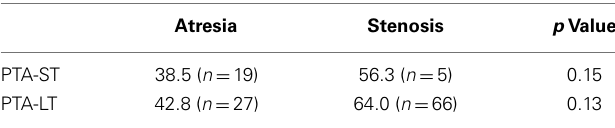
Table 8 | Comparison of short and long-term pure-tone threshold average in EACR group .